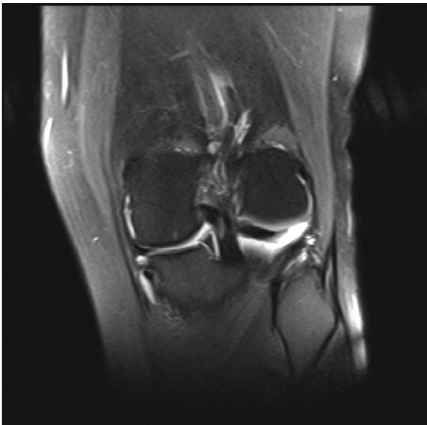
Figure 2: Sagittal MR image demonstrates “absence of the bow tie